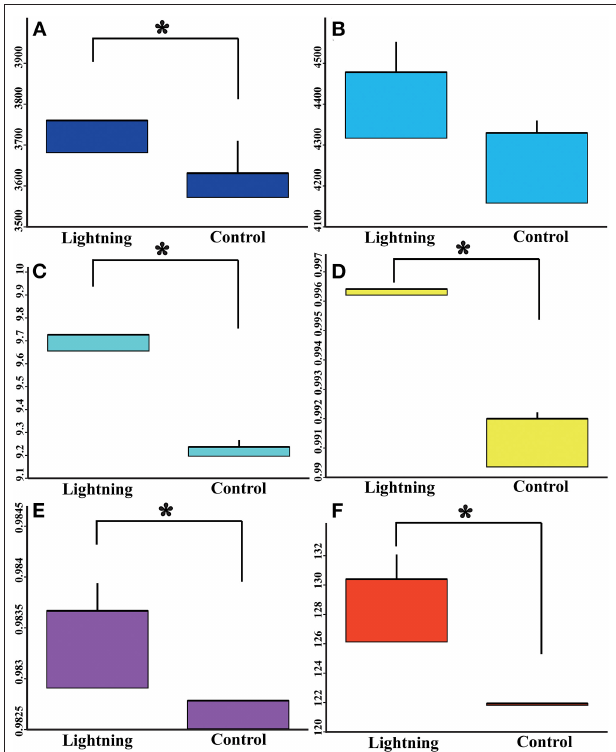
FIGURE 2 | Box diagram of alpha diversity index of different samples. Lighting represents a sample 10m from the lightning rod; Control indicates that the distance between the sample and the lightning rod is > 1,500m. *Indicates significant differences between different samples at the level of P < 0.05. (A) observed species index; (B) Chao 1 index; (C) Shannon index; (D) Simpson index; (E) , goods coverage; (F) PD whole